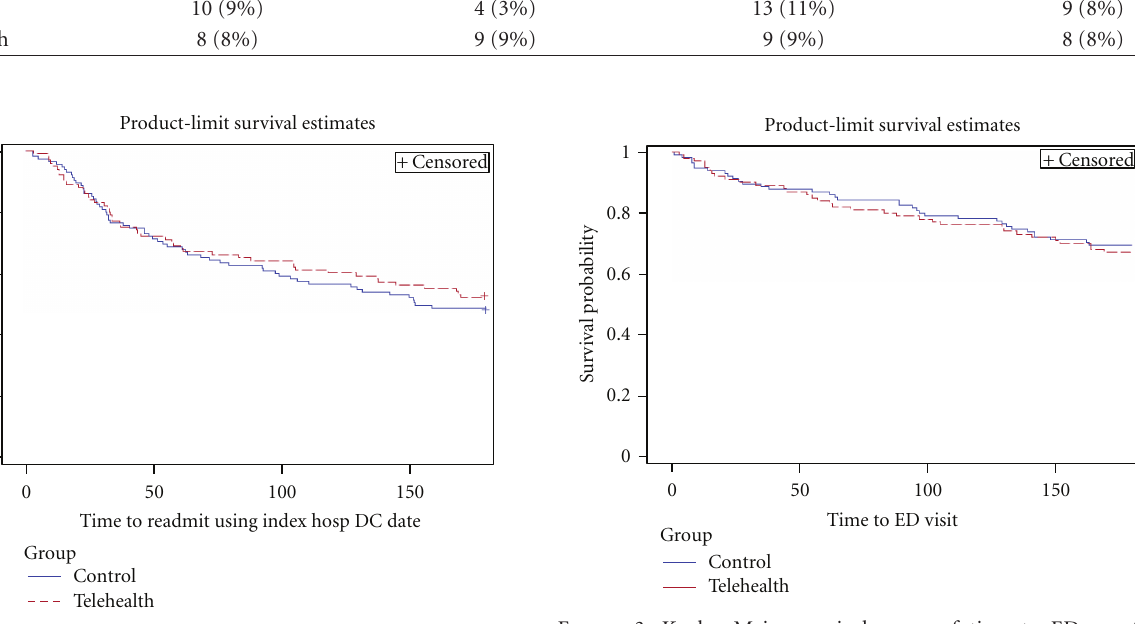
Figure 3: Kaplan-Meier survival curve of time to ED use for telehealth group versus control usual care group (LR P -value = 0 .